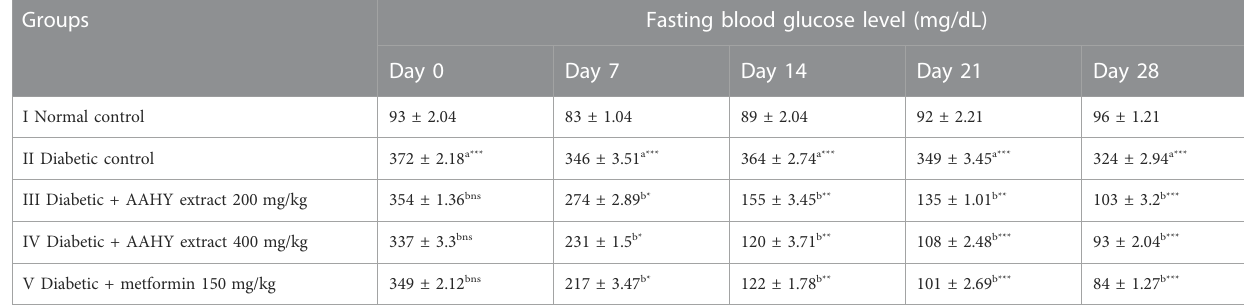
TABLE 3 Effect of the AAHY extract on fasting blood glucose (mg/dL). Groups